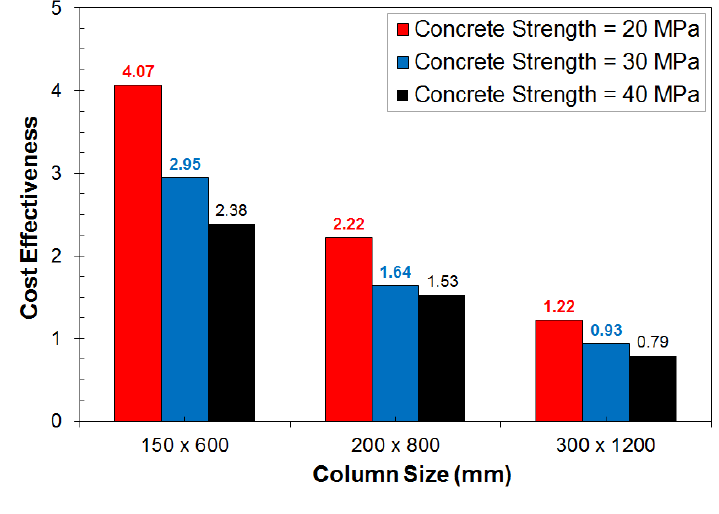
Figure 12. Cost effectiveness of SFRP confined concrete columns with varying column sizes and concrete